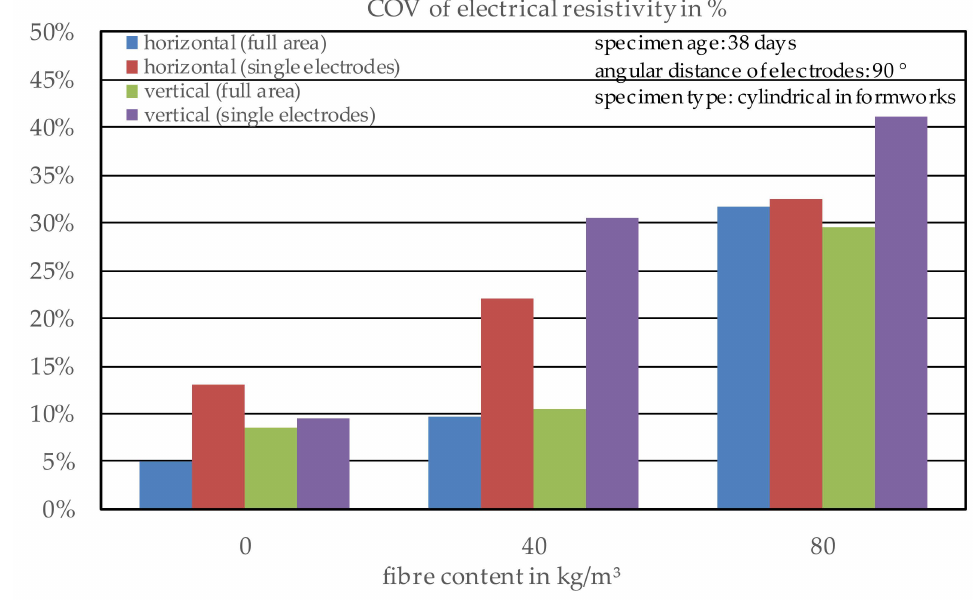
Figure A5. Coefficient of variation of the electrical resistivity in different directions depending on the fibre content at a specimen age of 38 days and an electrode array with angular distances of 90 ◦ .